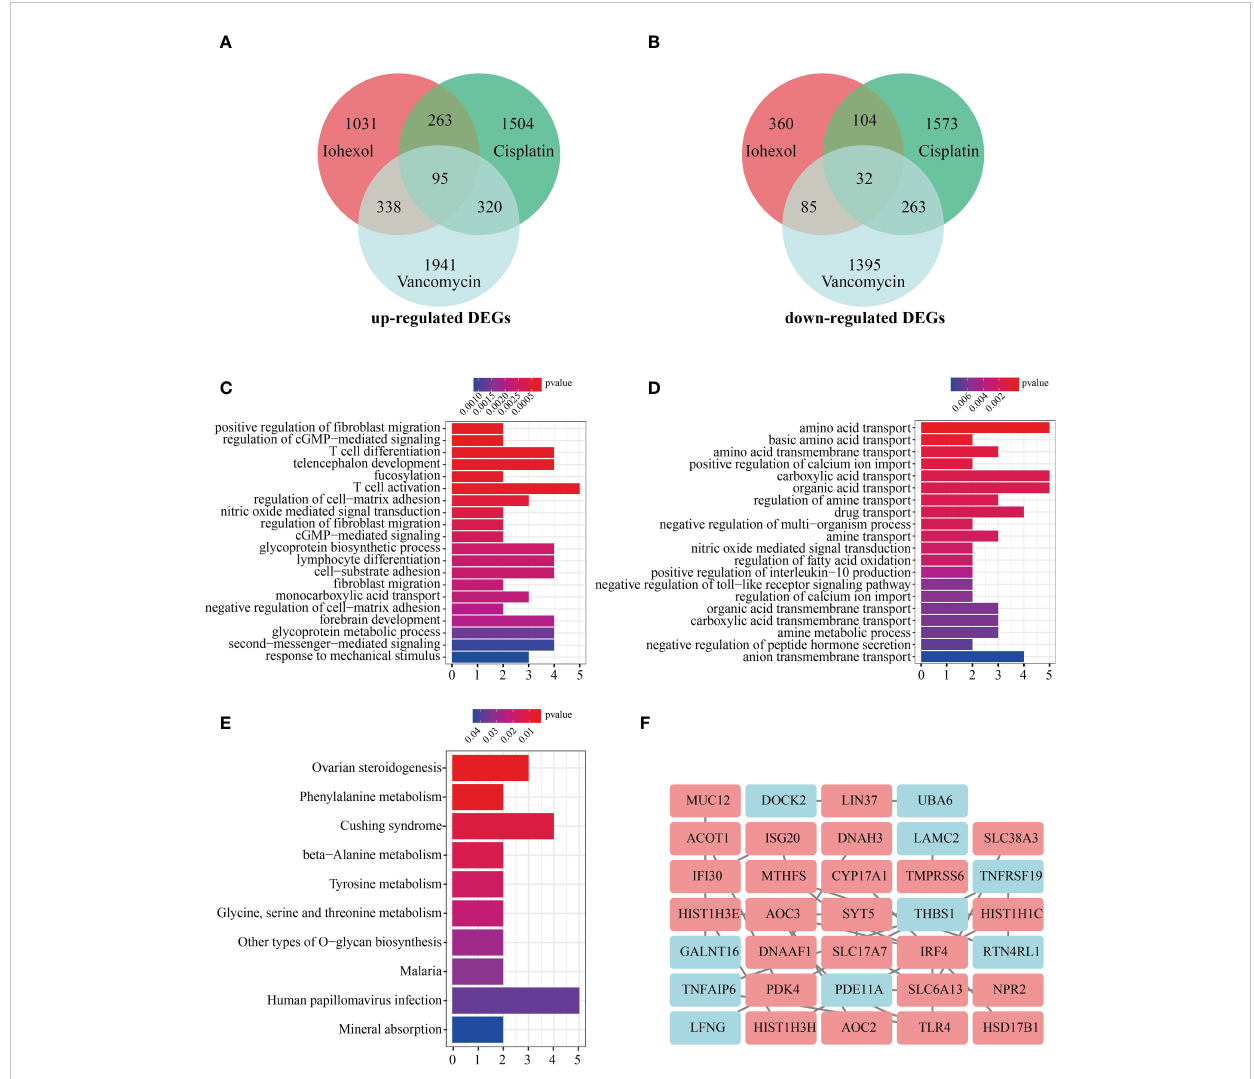
FIGURE 3 Enrichment analysis of co-DEGs and PPI network construction. (A) Vene diagram indicates intersection of up-regulated DEGs in three AKI datasets. (B) Intersection of down-regulated DEGs in three AKI datasets. (C) The GO enrichment (BP, CC and MF) of up-regulated co-DEGs. (D) The GO enrichment (BP, CC and MF) of down-regulated co-DEGs. (E) KEGG analysis of co-DEGs. (F) PPI network construction of 34 co-DEGs interaction with each other. Upregulated co-DEGs are marked in red while downregulated co-DEGs are marked in blue BP, biological process; CC, cellular component; MF, molecular function; KEGG, Kyoto Encyclopedia of Genes and Genomes; PPI, protein-protein interaction